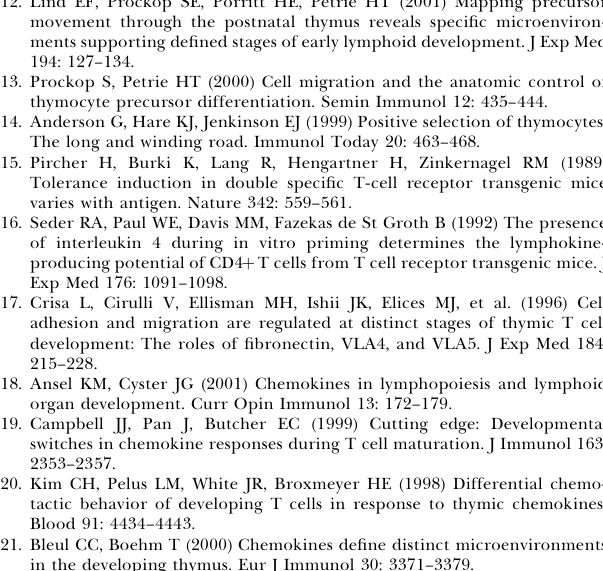
Figure S7. Displacement Analyses of P14 MR hi